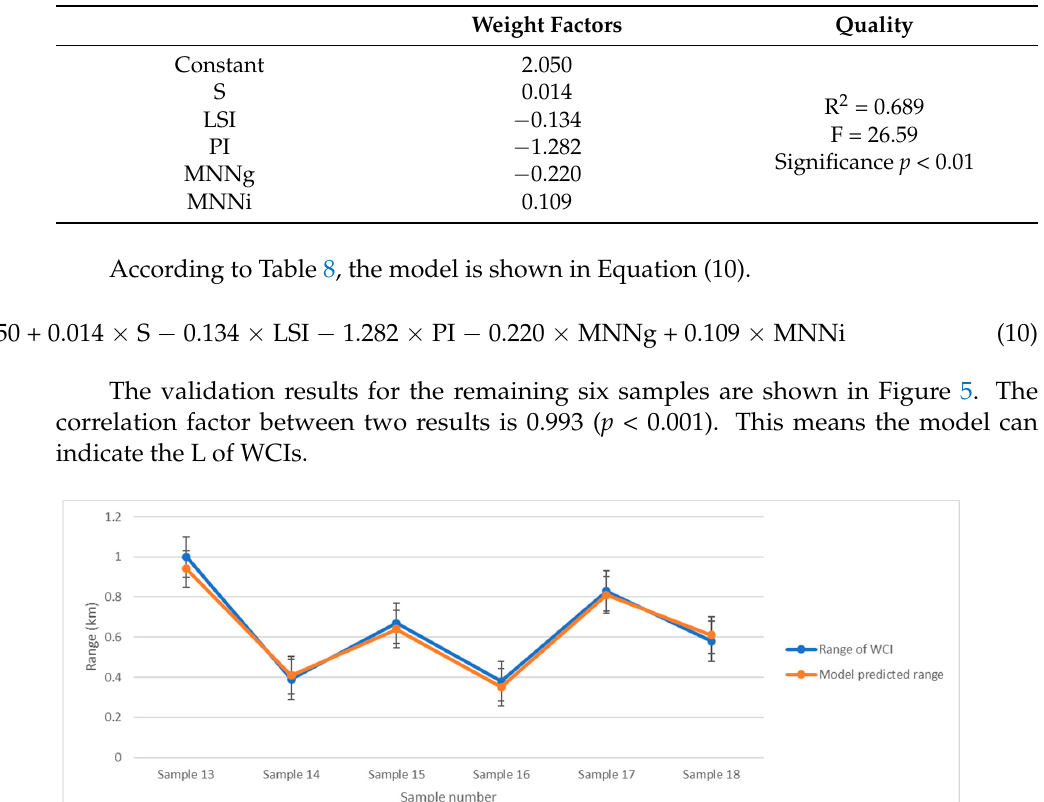
Table 8. Regression analysis results for WCI range and impact factors.